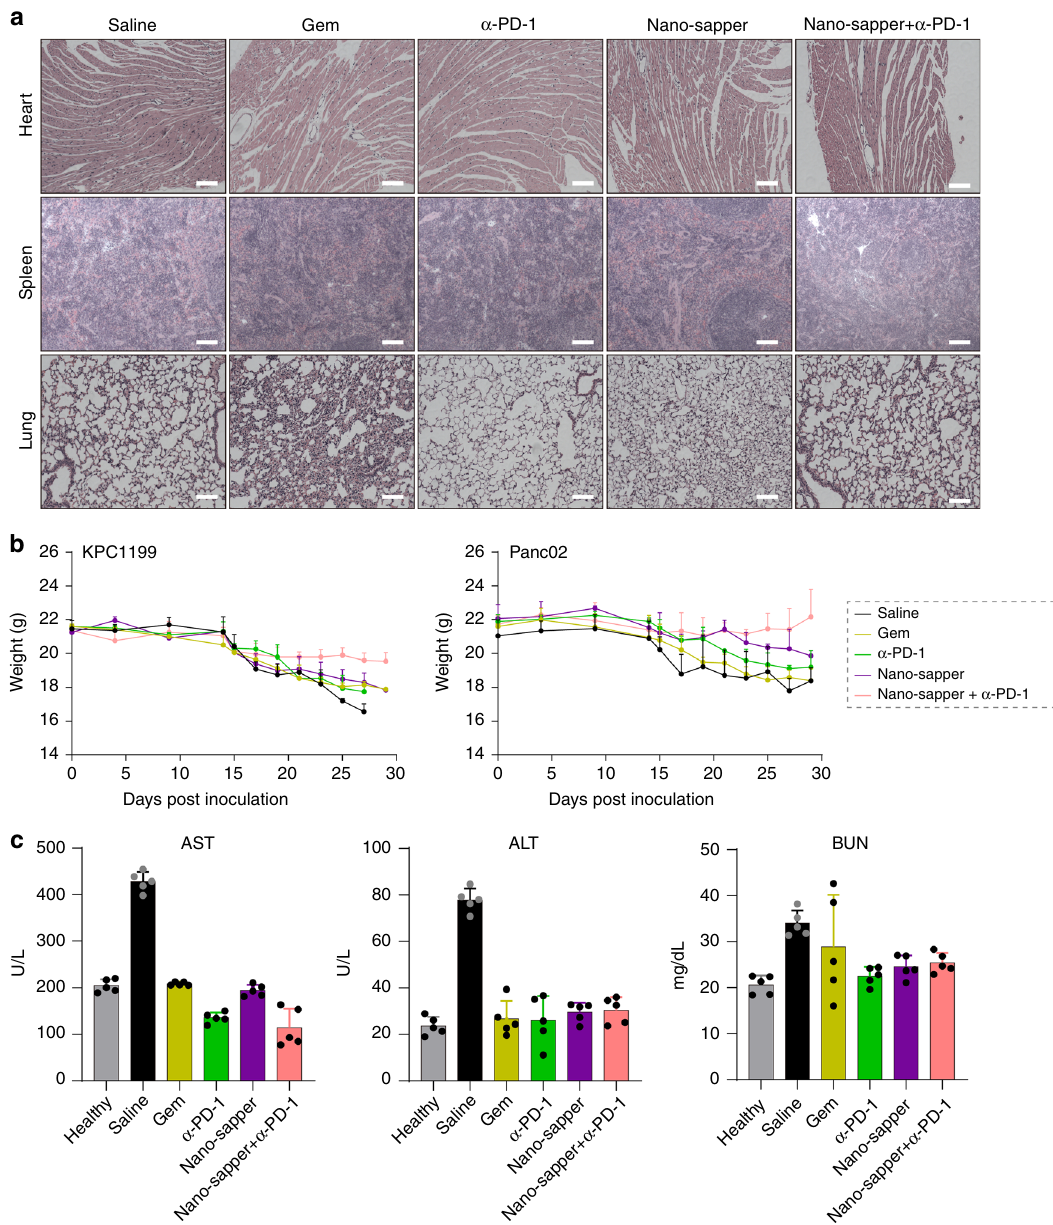
Fig. 9 Biosafety evaluation of different treatments. a H&E staining histology of heart, spleen and lung to evaluate the safety of different treatments. Scale bars, 100 μ m. Data were pooled from three independent experiments. b The body weight of mice monitored during the therapy ( n = 6 mice). c Systemic cytotoxicity evaluation of different treatments ( n = 5 mice). ALT, serum alanine aminotransferase; AST, aspartate aminotransferase; BUN, blood urea nitrogen. Data are presented as mean ± s.d. Error bars represent s.d. Source data of ( b ) and ( c ) are provided as a Source Data fi Methods Materials . (2,3-dioleoyloxy-propyl)-trimethylammonium (DOTAP) and 1,2-dio- leoyl-sn-glycero-3-phosphate (DOPA) were obtained from Avanti Polar Lipids (Alabaster, AL, USA). 1,2-distearoyl-sn-glycero-3-phosphoethanolamine-N- [amino(polyethylene glycol)-2000] (ammonium salt) (DSPE-PEG2000) was obtained from Xi ’ an Ruixi biotech (Xi ’ an, China). FHK peptide (FHKHKSPALSPV) was synthesized by China Peptides Co., Ltd (Shanghai, China). Low molecular weight protamine (LMWP), IGEPAL ® CO-520, cholesterol, 1,1 ′ - dioctadecyl-3,3,3 ′ ,3 ′ -tetramethylindotricarbocyanine iodide (DiR), 3-[4,5-dime- thylthiazol-2-yl]-2,5-diphenyl tetrazolium bromide (MTT), 4,6-Diamidino-2-phe- nylindole (DAPI), Hoechst 33258 and phosphatase inhibitor cocktails were provided by Sigma-Aldrich (St. Louis, MO, USA). α -M were purchased from Biopurify Co., Ltd (Chengdu, China). Collagenase type IV (40510ES60), hyalur- onidase (20426ES60), DNase I (10608ES25) and Agar (70101ES76) were purchased from Shanghai yeasen biotech (Shanghai, China). Tryptone (LP0042) and Yeast extract (LP0021) were obtained from OXOID. Gemcitabine was obtained from Eli